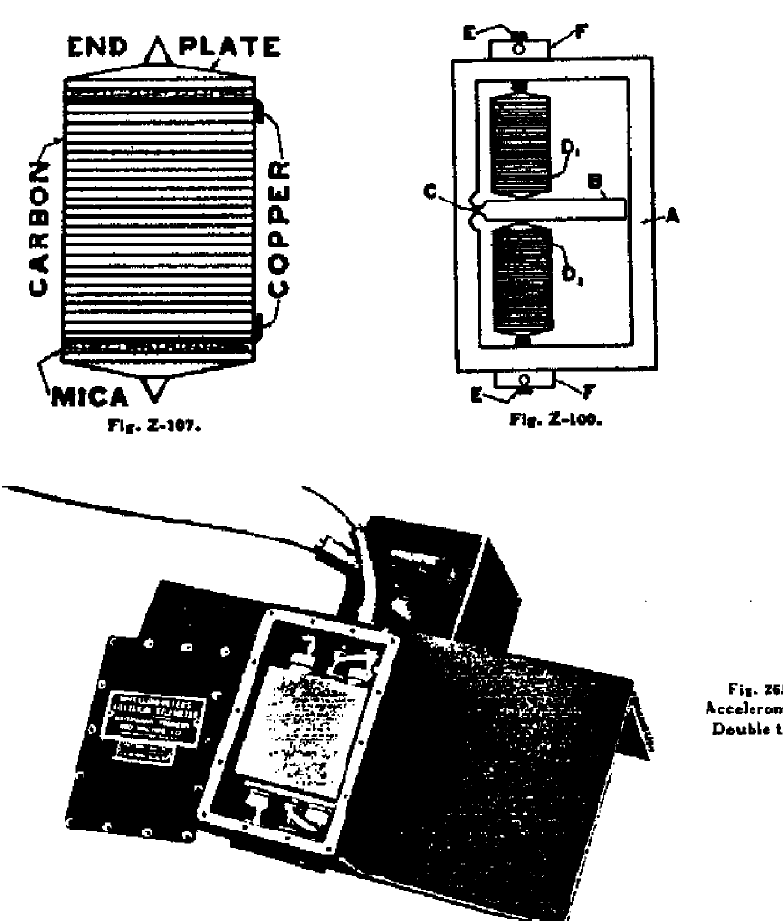
Fig. 1. The first commercial resistance-bridge accelerometer (McCollum and Peters, photo date